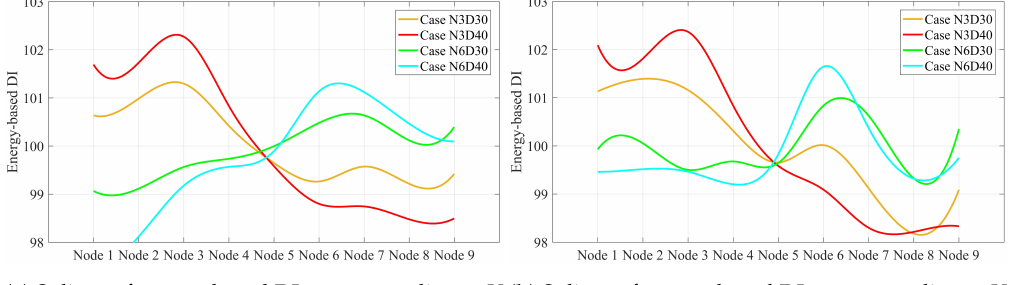
Figure 14. Splines of noisy energy-based DIs along the simply supported beam related to velocities ( a ) 2.5 m/s and ( b ) 4